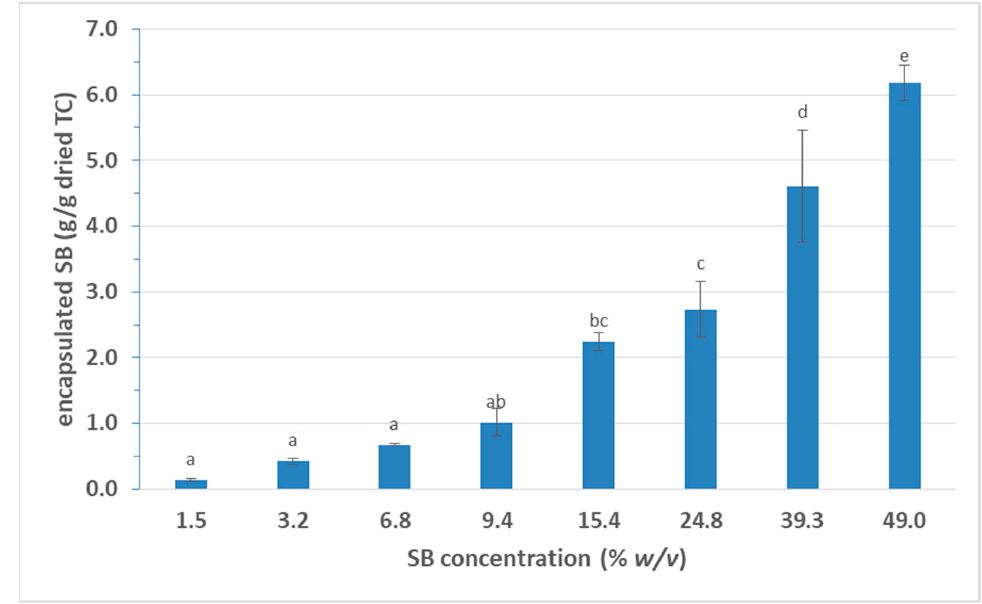
Figure 2. Effect of SB concentration on encapsulation of SB in dried TC. (SB: sodium benzoate; TC: tubular cellulose; means with different superscripts differ significantly ( p < 0.05)).